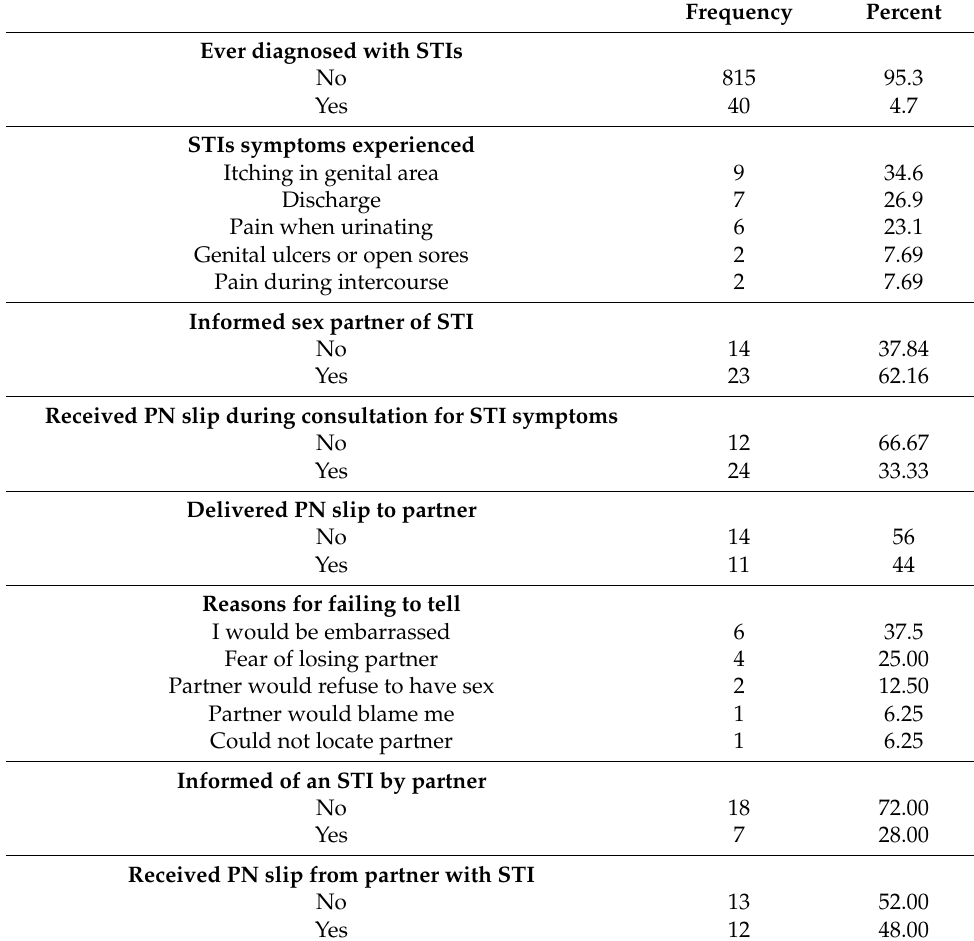
Table 5. Partner notification practices among students who self-reported STI in the past 12